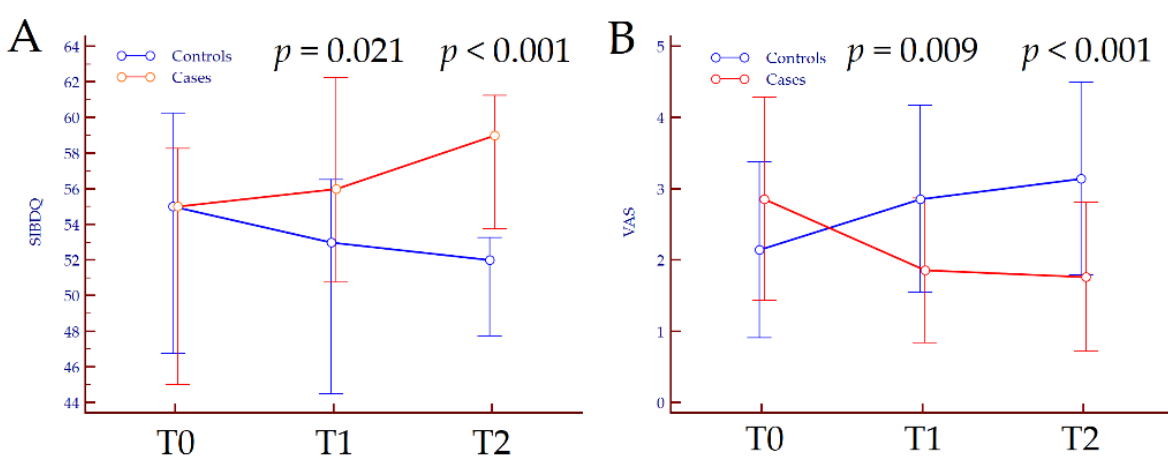
Figure 2. Variation of Short Inflammatory Bowel Disease Questionnaire score ( A ) and visual analogue score ( B ) from T0 to T2 according to treatment. p values refer to the comparison between groups at each time-point and were calculated by Mann–Whitney. Abbreviations: SIBDQ, Short Inflammatory Bowel Disease Questionnaire; T, timepoint; VAS, visual analogue scale.